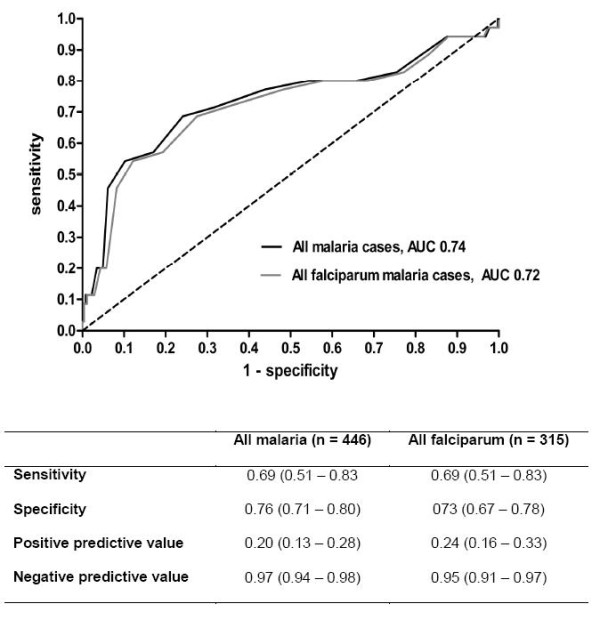
Receiver operating characteristics curve of serum sodium concentration for malaria severity.